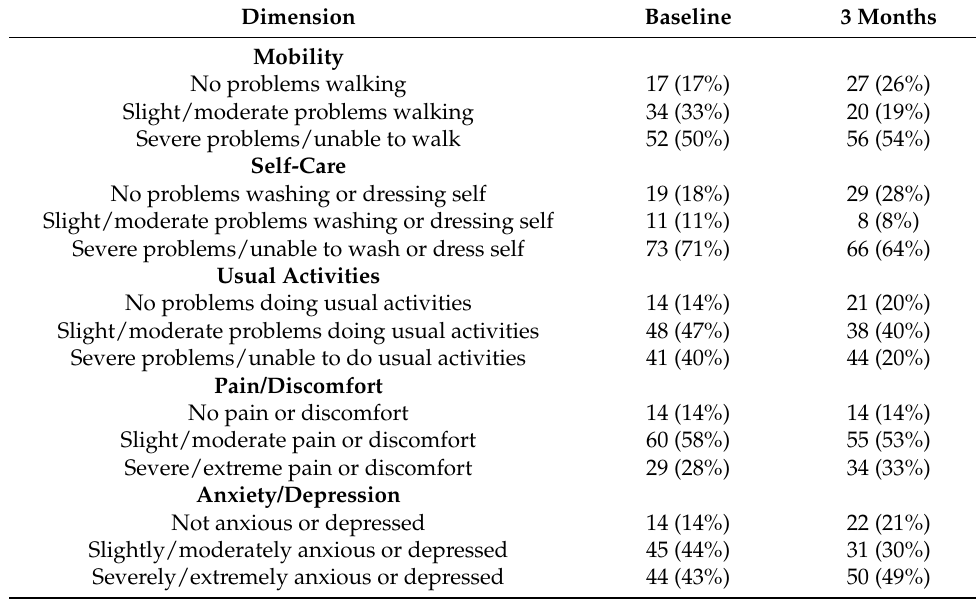
Table 5. The number (%) of CARE respondents reporting baseline and 3 EQ-5D domains.